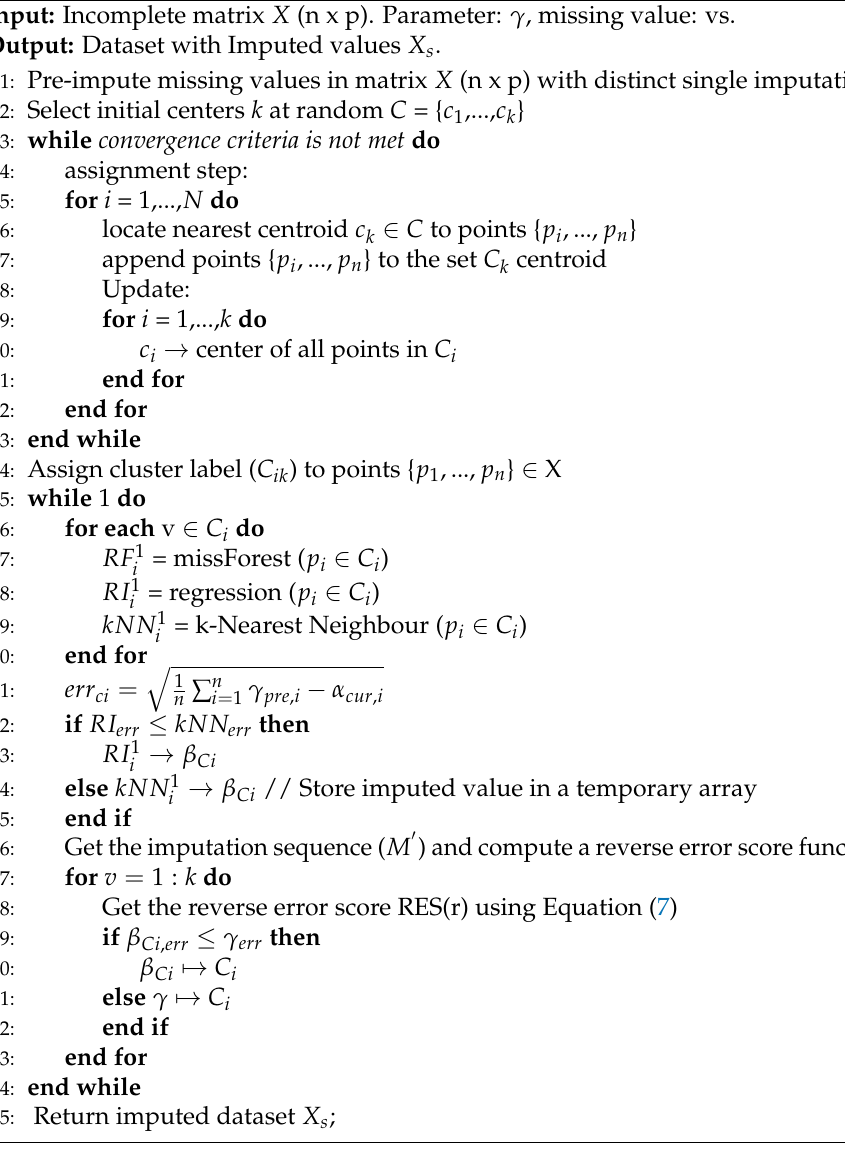
Algorithm 1 k -Best Fit Estimation